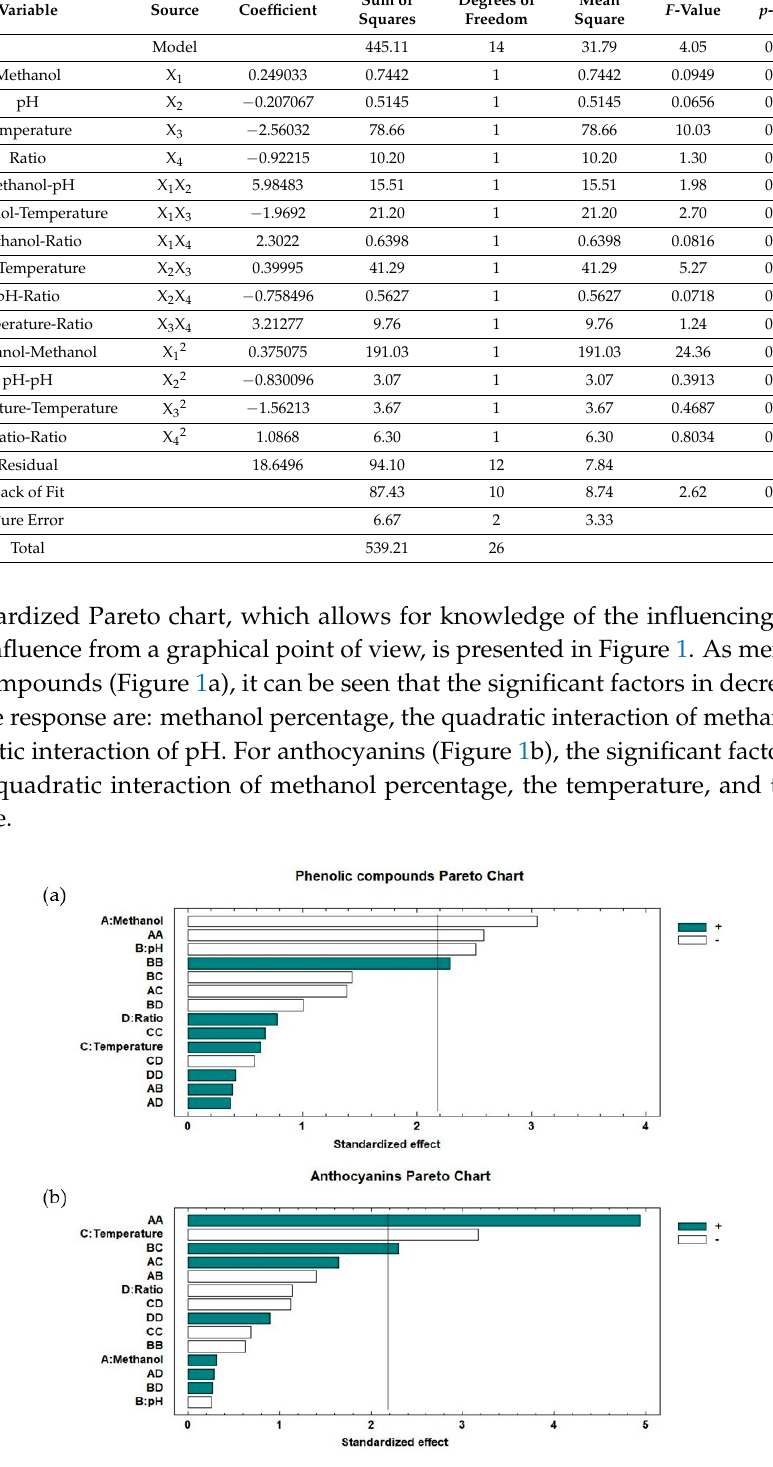
Figure 1. Standardized Pareto charts for: ( a ) total phenolic compounds; ( b ) anthocyanins.